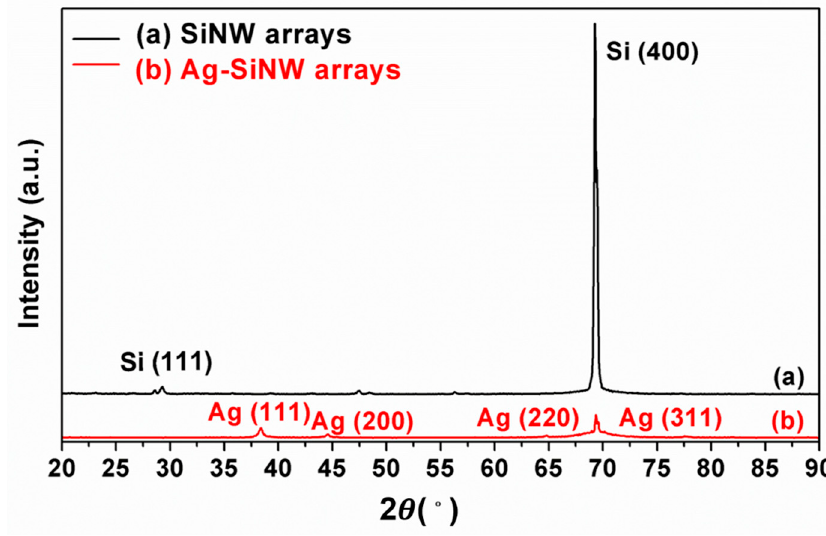
Figure 4. X-ray diffraction spectra of ( a ) the p-SiNW arrays and ( b ) the SiNWs deposited with AgNPs.